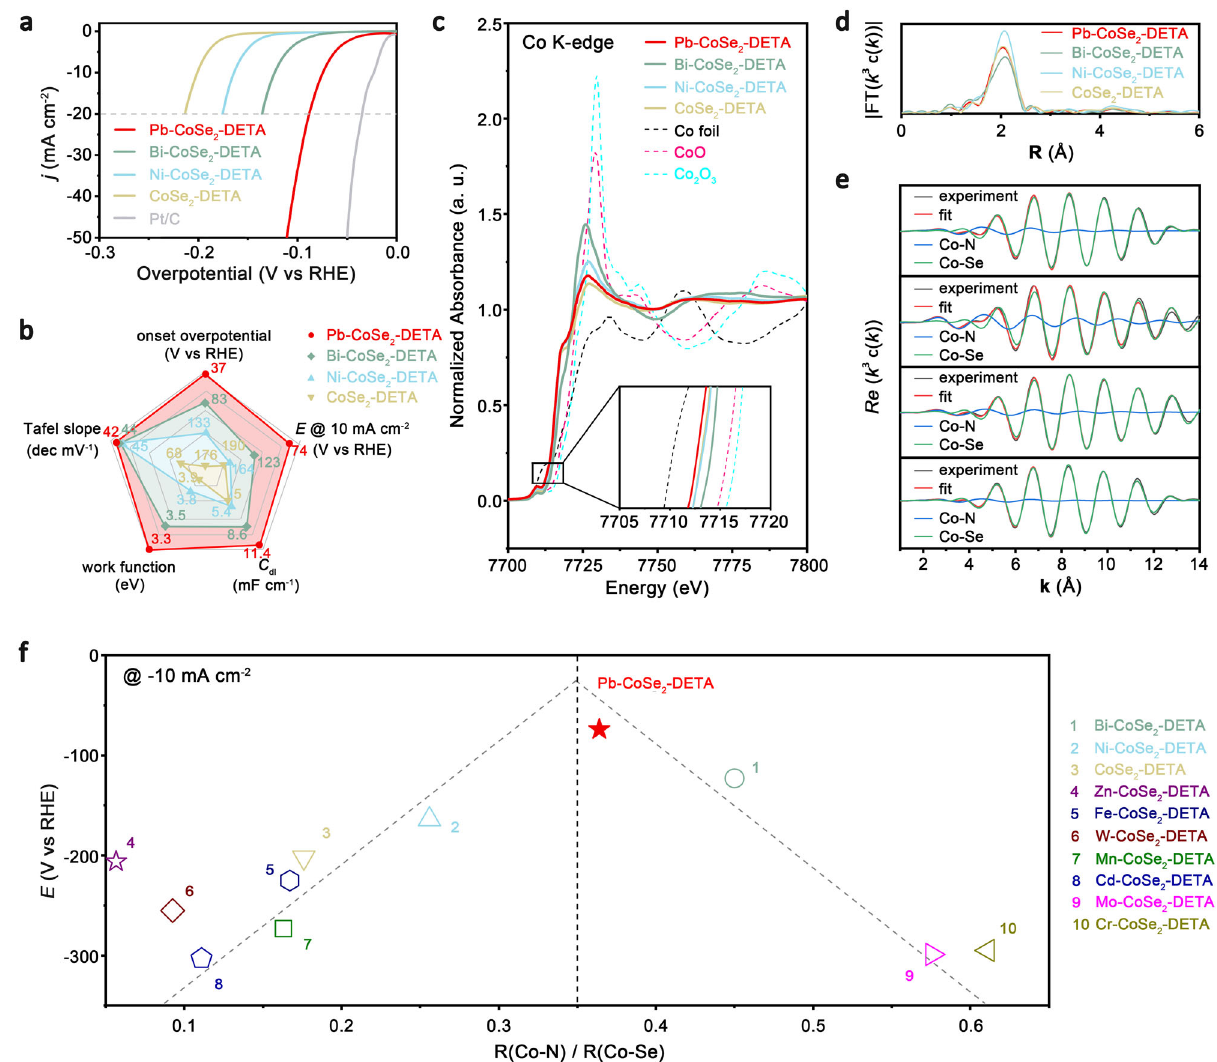
Fig. 4 | HER performance and activity descriptor. a Electrocatalytic HER of Pb-, Bi-, Ni-CoSe 2 -DETA, pure CoSe 2 -DETA and commercial Pt/C in 0.5M H 2 SO 4 . b Activity comparison of Pb-, Bi-, Ni- CoSe 2 -DETA and pure CoSe 2 -DETA. c XANES spectra at Co K-edge of Pb-, Bi-, Ni-CoSe 2 -DETA, pure CoSe 2 -DETA, Co foil, CoO